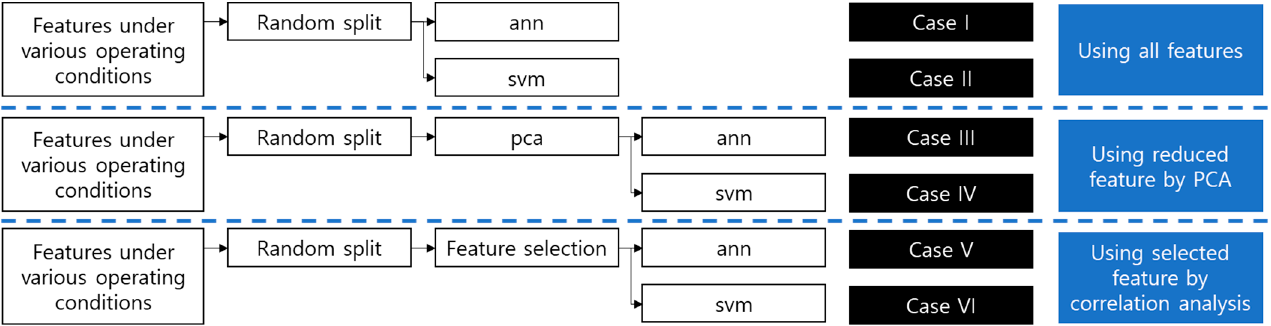
Figure 11. Description of the case study.